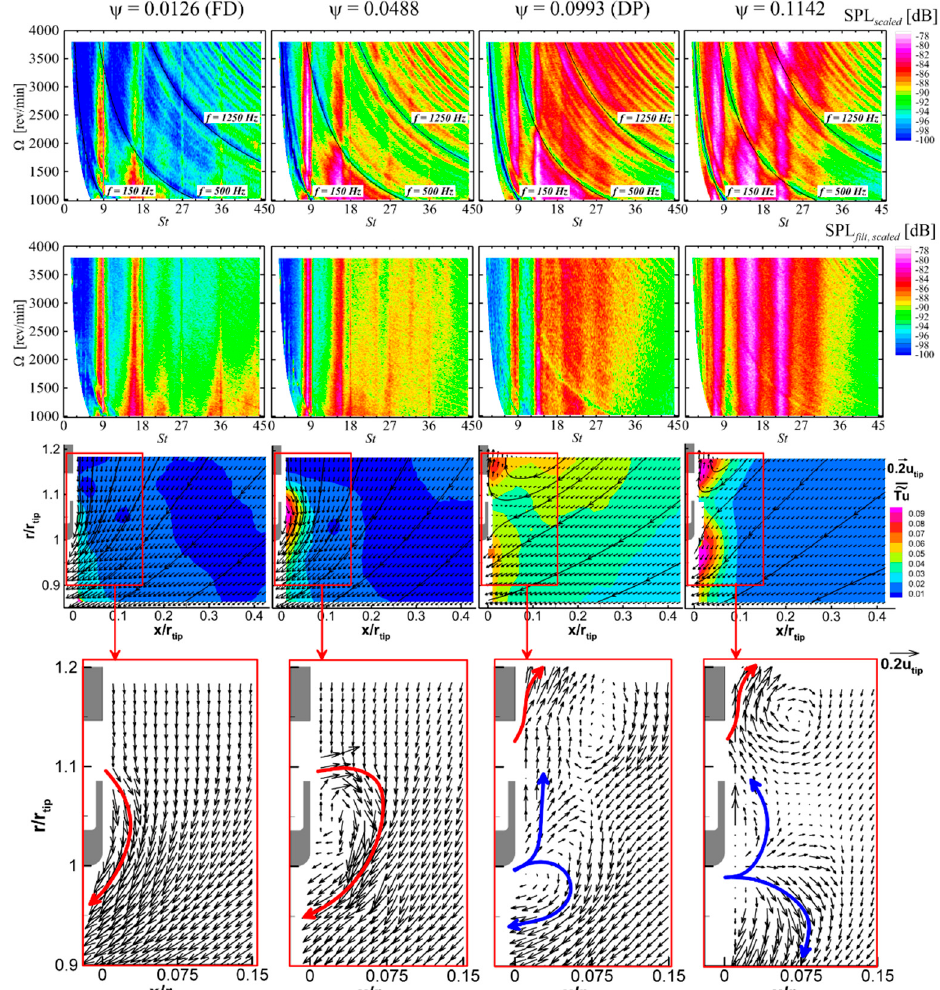
Figure 8. Measurements taken at Ψ = const . From top to bottom: Spectrograms of SPL scaled and of SPL filt,scaled during speed ramps, and time-mean and instantaneous flow fields at Ω = 2500 rev/min ( → leakage flow, → blade tip separation). From left to right: Ψ = 0.0126, 0.0488, 0.0993, 0.1142.